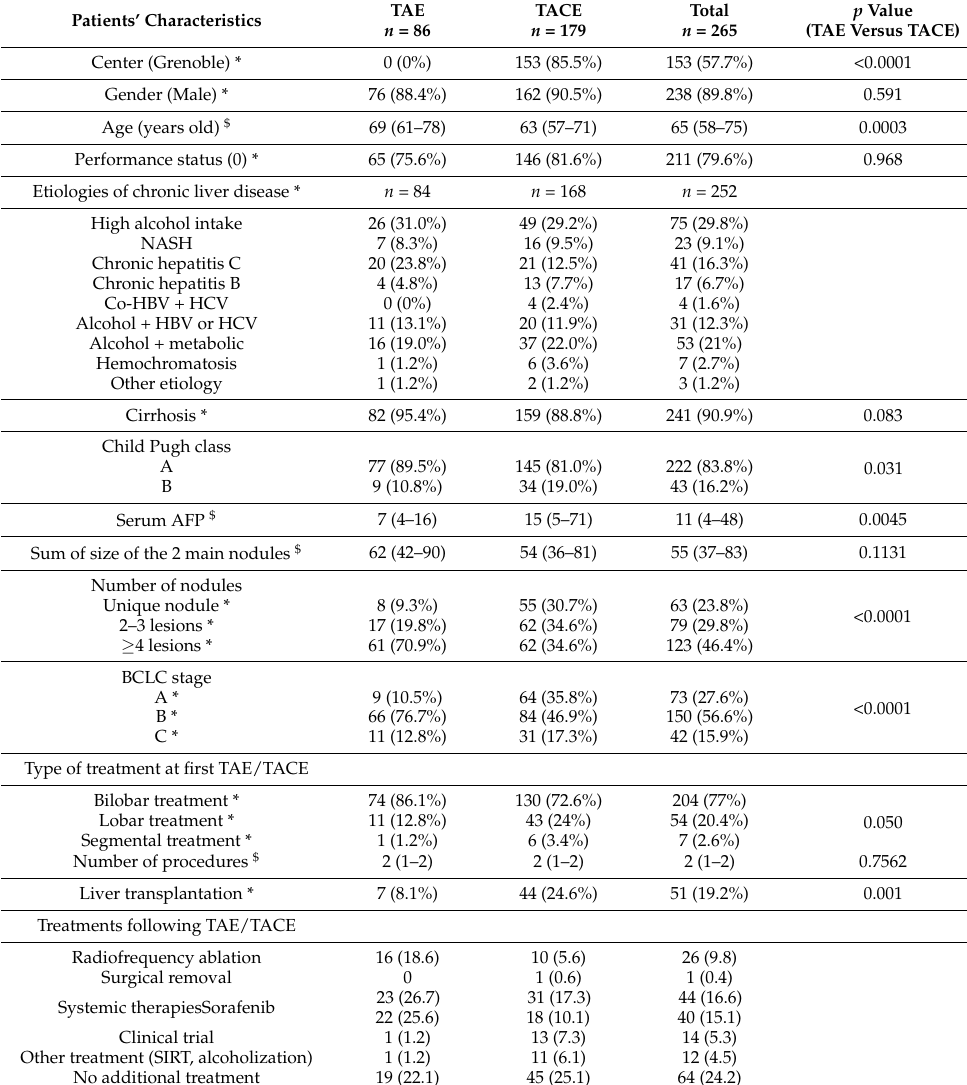
Table 1. Description of the